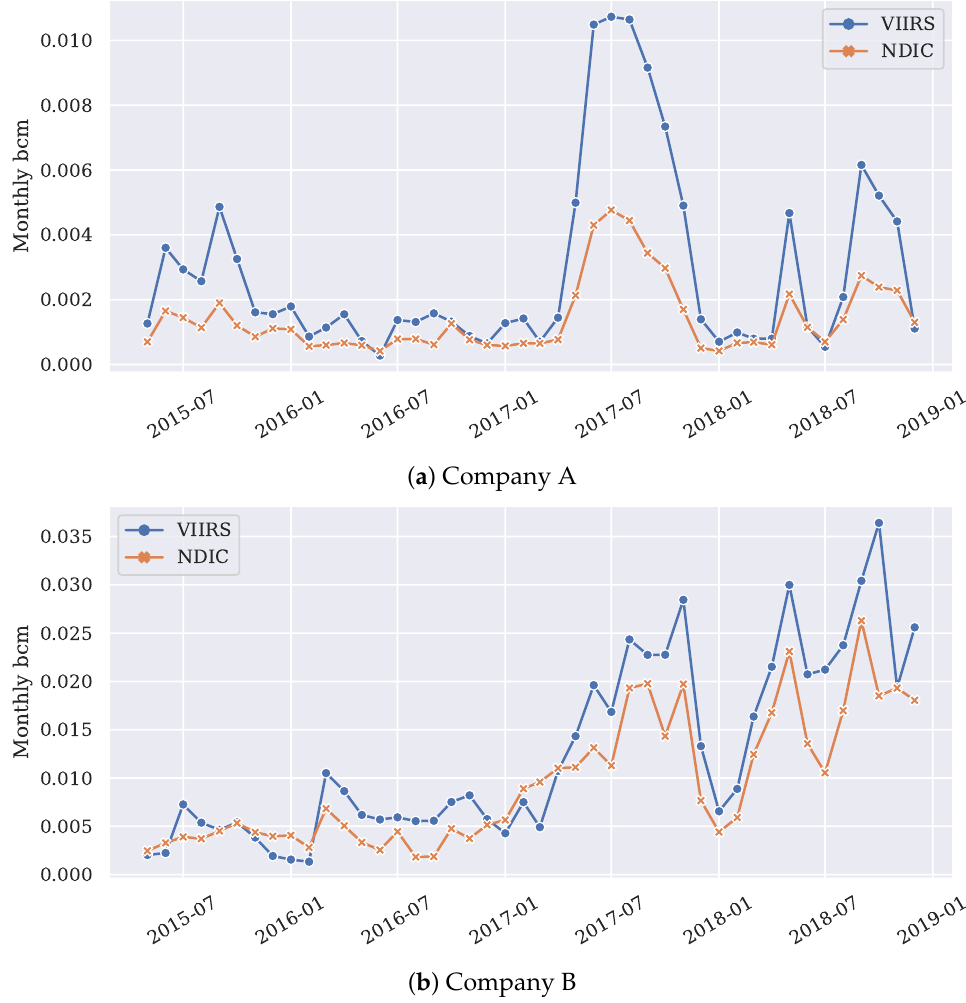
Figure 26. Time series of the two example companies whose reporting shows a good match with the VIIRS records. For Company A, the two time series have the same dominating trends and are highly correlated (Figure